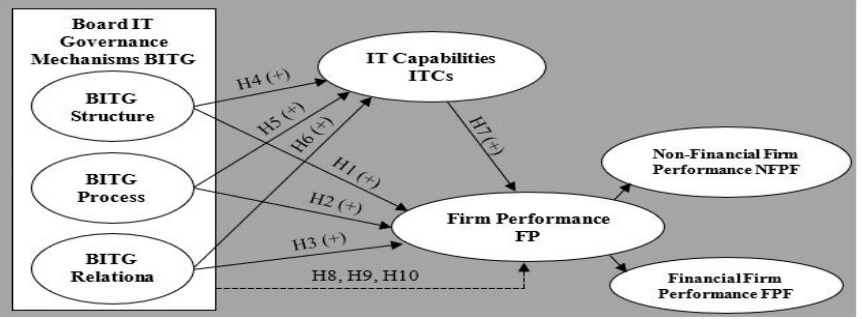
Figure 1. Proposed Conceptual Framework. Table 1. Sample Responses Classification by Sectors and Respondents. Panel A: Sample classification by